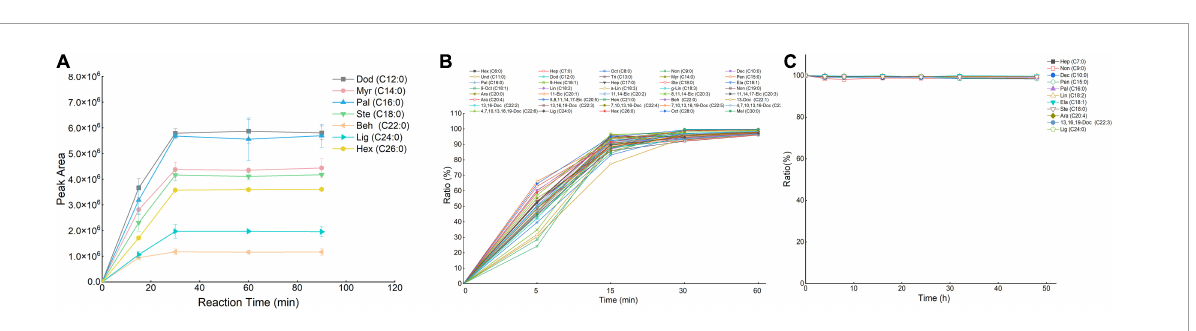
FIGURE3 Effect of conversion efficiency of fatty acids (FAs) standards (A) and FAs in meat (B) . The stability study (C) of 5-(dimethylamino)-1-carbohydrazide-isoquinoline (DMAQ)-derivatized FAs at 4 ◦ C. Data were represented as the mean ± standard deviation ( n =